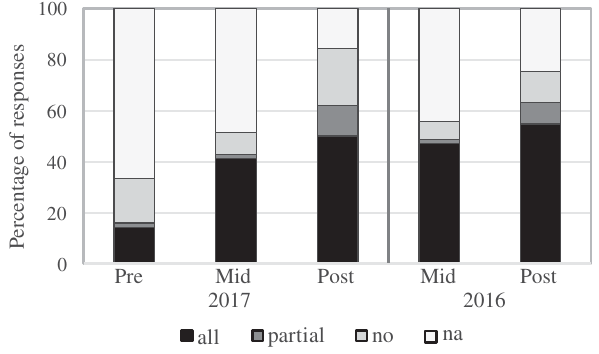
FIG. 6. The percentage of responses with fully consistent (all), partially consistent (partial), and inconsistent (no) use of repre- sentations across the pre-, mid-, and post-test responses. Code na was used for students ’ responses with only a single representation or with no